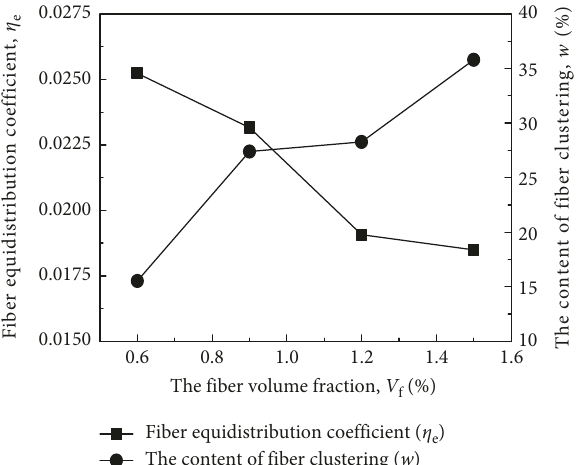
Figure 9: Fiber equidistribution coefficient and content of fiber clustering as a function of fiber volume fraction.